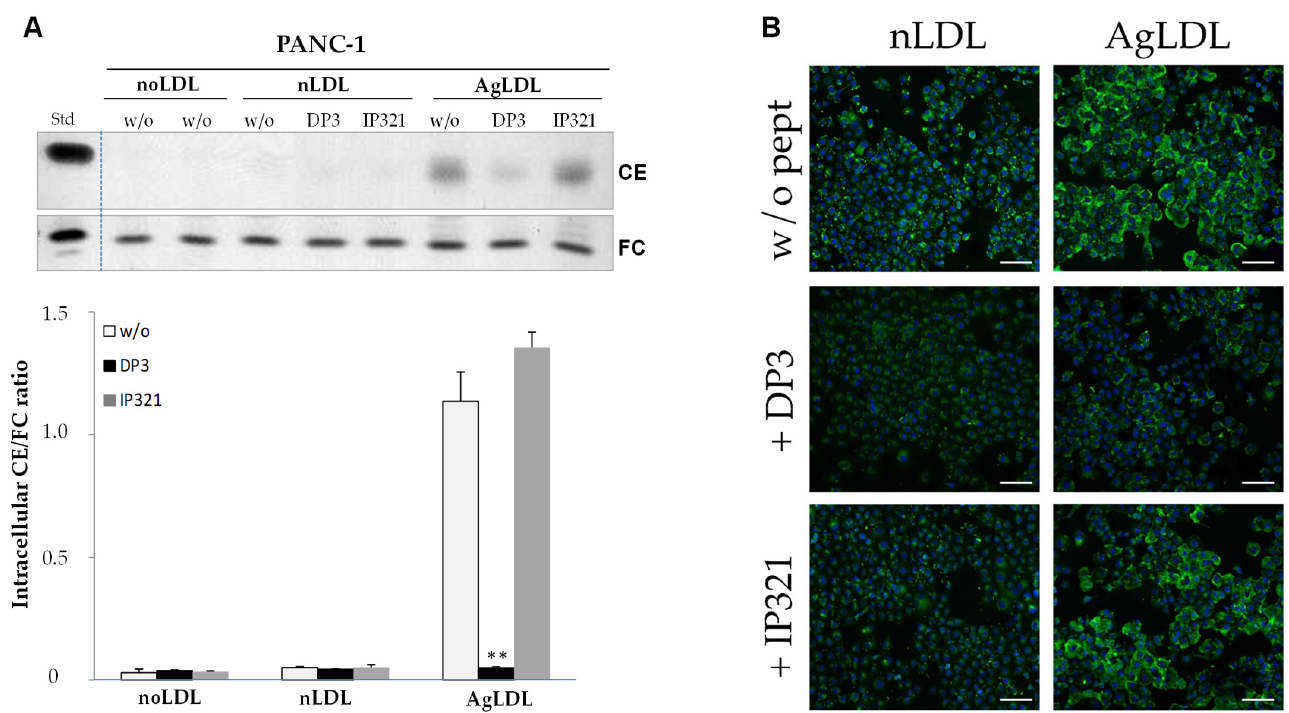
Figure 5. Effect of peptides DP3 and IP321 on the intracellular CE/FC ratio and lipid droplet formation induced by nLDLs and AgLDLs in PANC-1 cells. Cells were untreated (noLDL) or treated with nLDLs or AgLDLs in the absence (w/o peptide) or presence of DP3 or IP321 (10 µ M, 2 h). ( A ) Representative thin layer chromatography (TLC) image showing CE and FC bands and bar graph showing the intracellular CE/FC ratio in PANC-1. Data are shown as the mean ± SEM of three experiments performed in triplicate. ** p < 0.001. Statistical significance was determined by Student’s t test. ( B ) Confocal laser microscopy images show BODIPY-stained lipid droplets (green dots) and nuclei (in blue). Scale bar, 100 µ m. CE, cholesteryl esters; FC, free cholesterol; LDL, low-density lipoprotein; nLDL, native LDLs; AgLDLs, aggregated LDLs. Detailed information can be found in Figure S8.